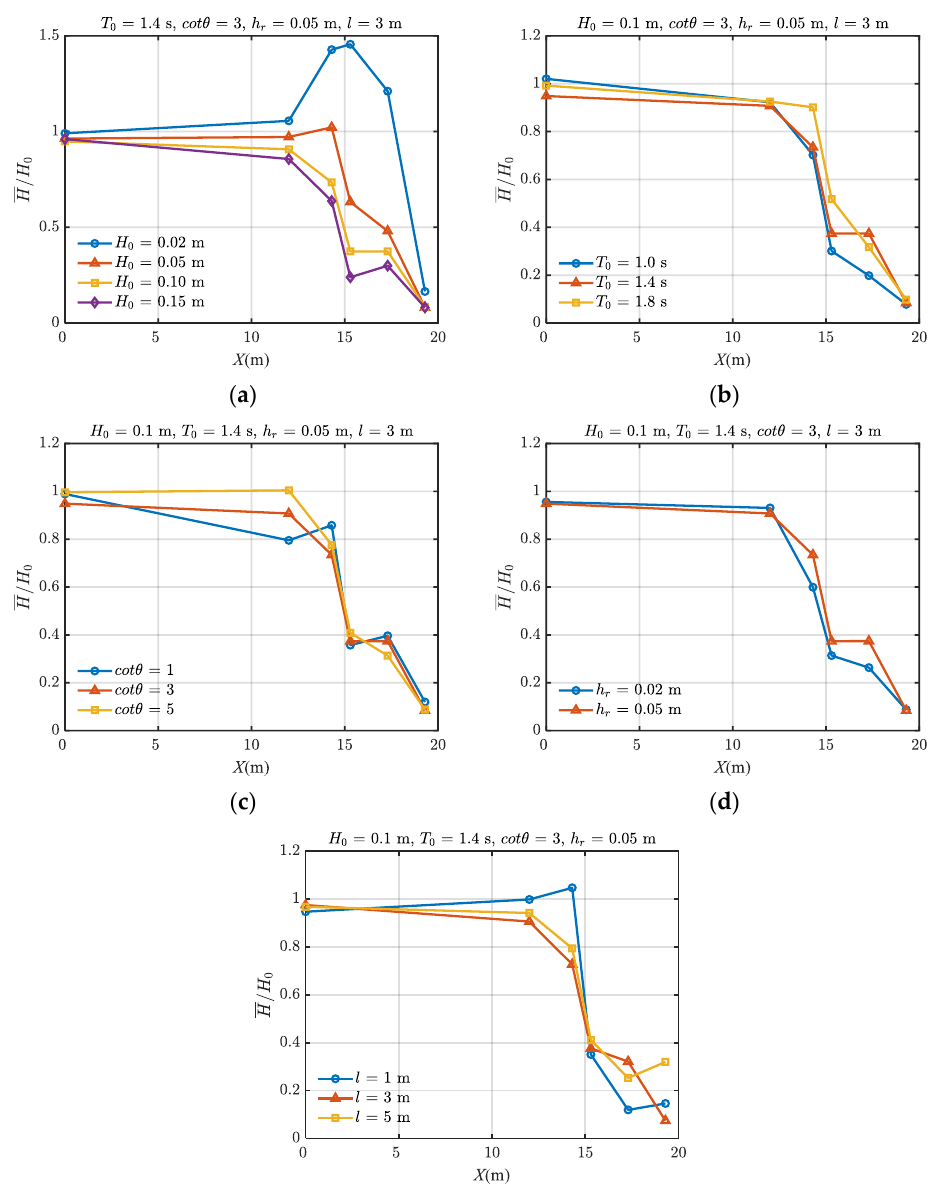
Figure 12. Regular wave height transformation for the sloped seawall on the reef flat for different cases: ( a ) H 0 ; ( b ) T 0 ; ( c ) cot θ ; ( d ) h r ; ( e ) l .